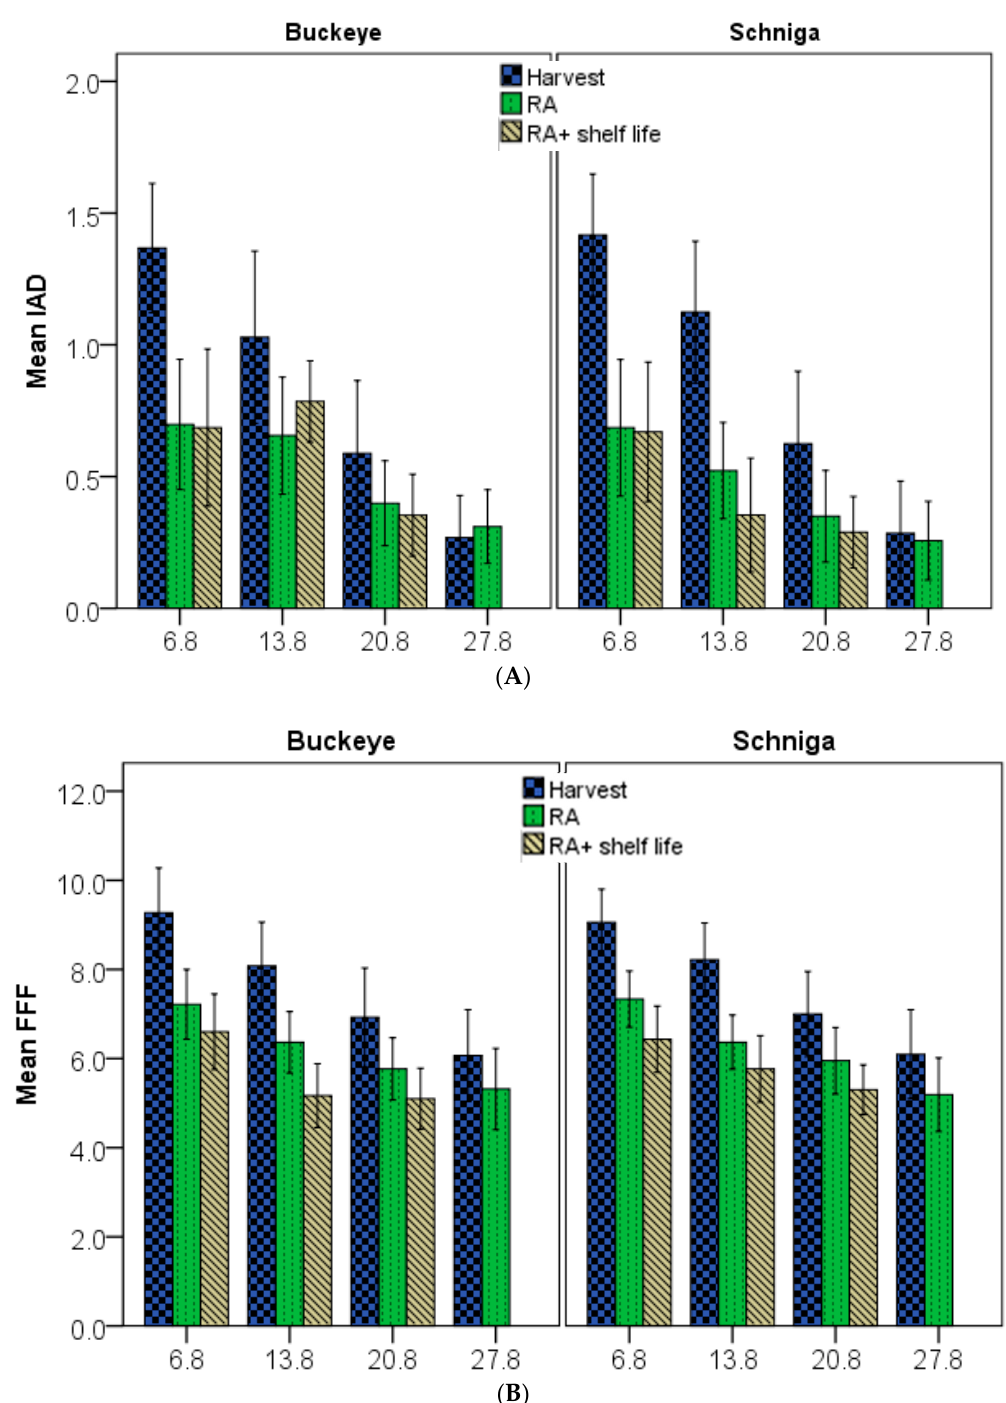
Figure 5. Changes (mean and standard deviation) during 2.5 months of regular atmosphere (RA) storage and subsequent seven days of shelf life for the 4 harvests, with the optimal harvest date at 13 August 2015. The dynamics is shown for inner and outer canopy fruit of cv. ‘Gala Buckeye’ in 2015 for ( A ) IAD and ( B ) fruit flesh firmness in kgF (FFF).